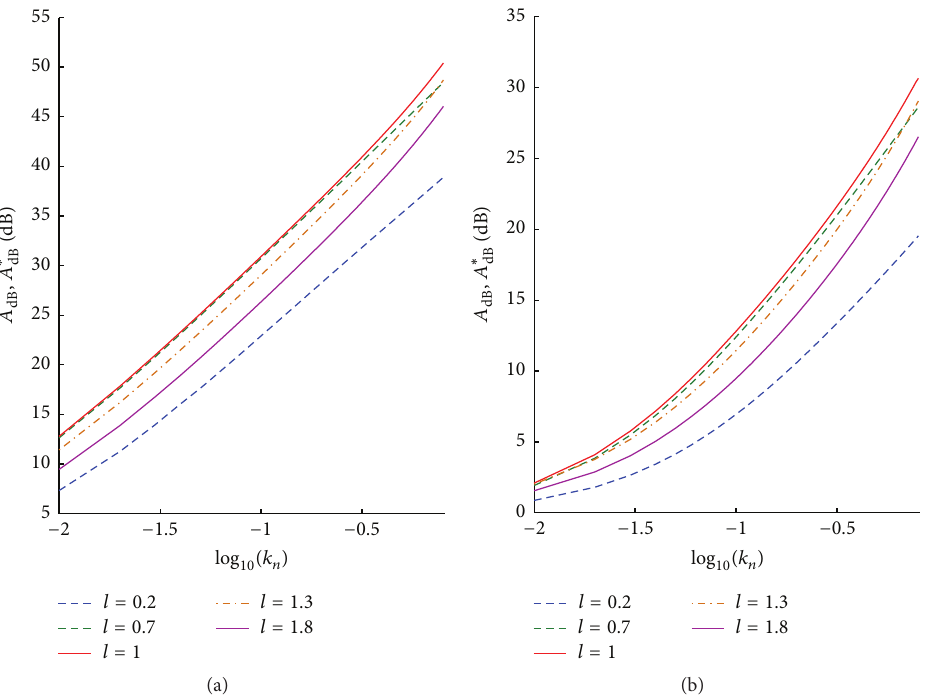
Figure 5: Relationship between 𝐴 dB or 𝐴 ∗ dB and log 10 𝑘 𝑛 for different 𝜉 𝑛 values: 0.1% (a) and 1% (b).